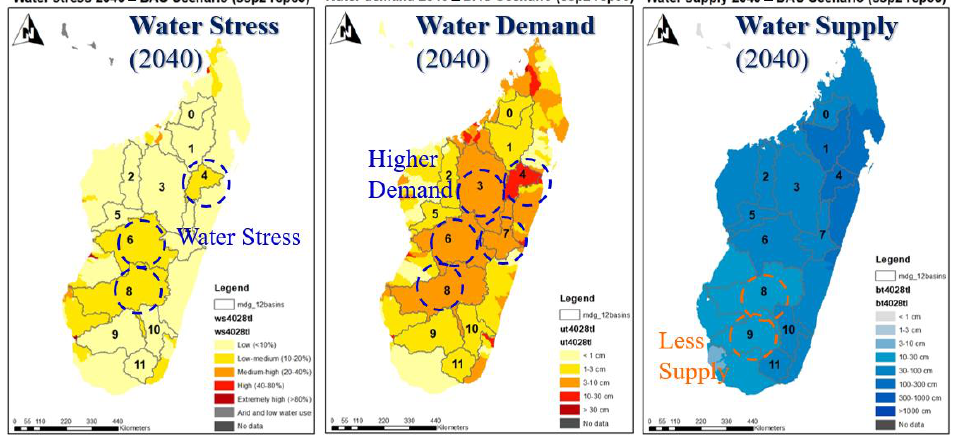
Figure 2. Projected change of water stress, water demand, and water supply from the baseline (1950 – 2010) to a future period (2040) under the business-as-usual scenario RCP8.5/SSP2. Source: WRI Aqueduct projections 2015 (Data available at https://www.wri.org/aqueduct accessed on 25 May 2020)